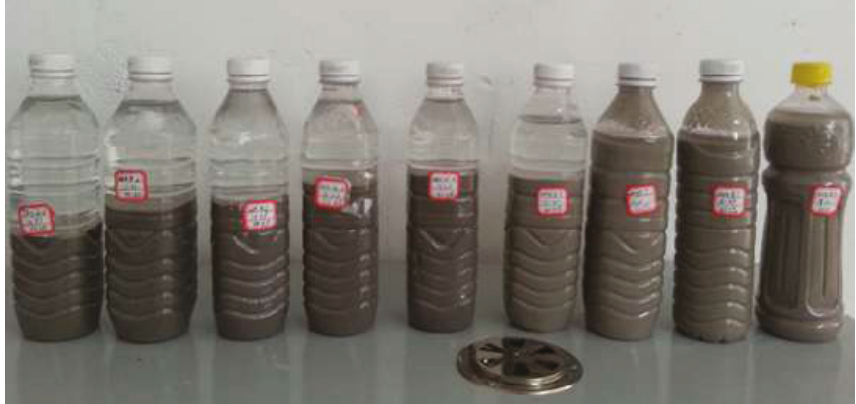
Figure 7: Bleeding water of PGBS in the bottles.